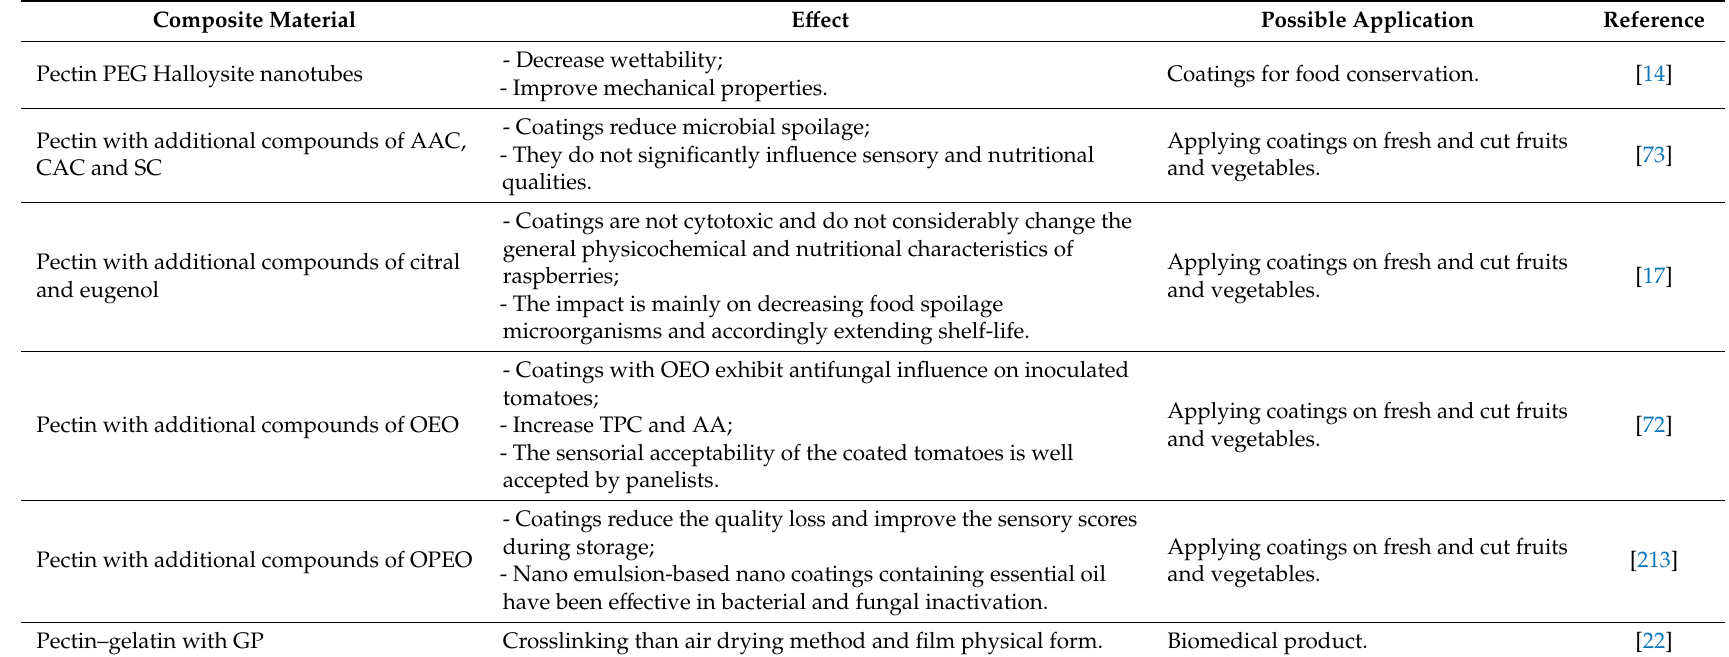
Table 3. Pectin properties used for di ff erent